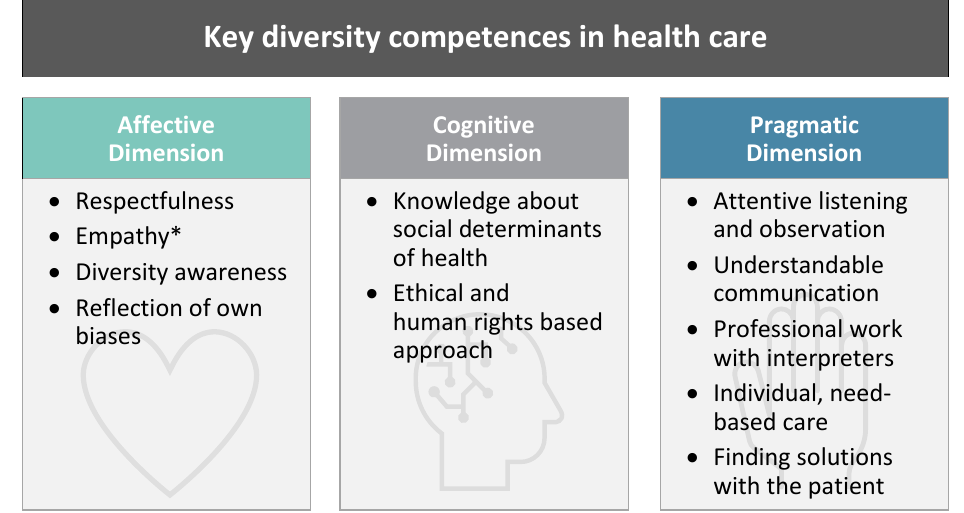
Figure 2. Key diversity competences. (* Empathy: in this summary, categorised as ‘affective’, formerly— in the questionnaire—assigned to the pragmatic dimension, within the ‘category patient centeredness and change of